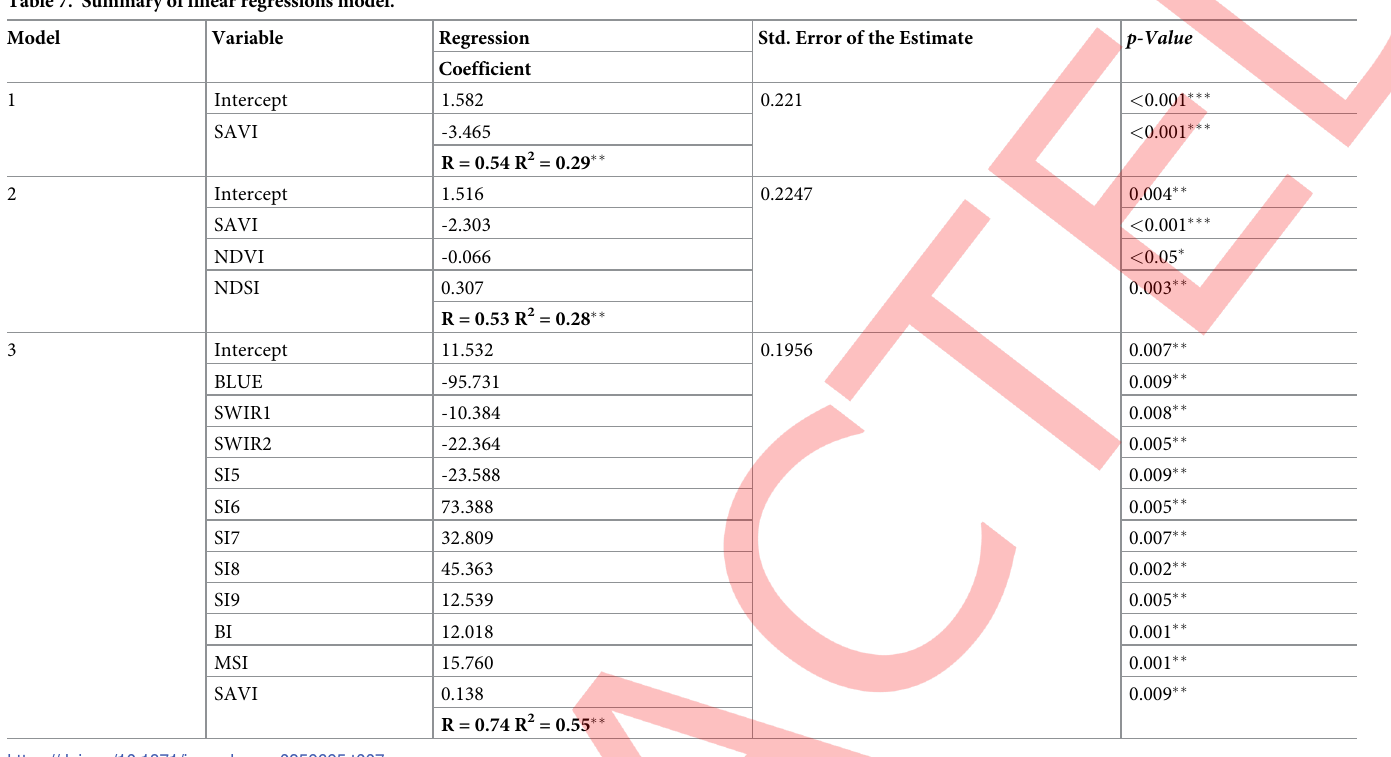
Table 7. Summary of linear regressions model.